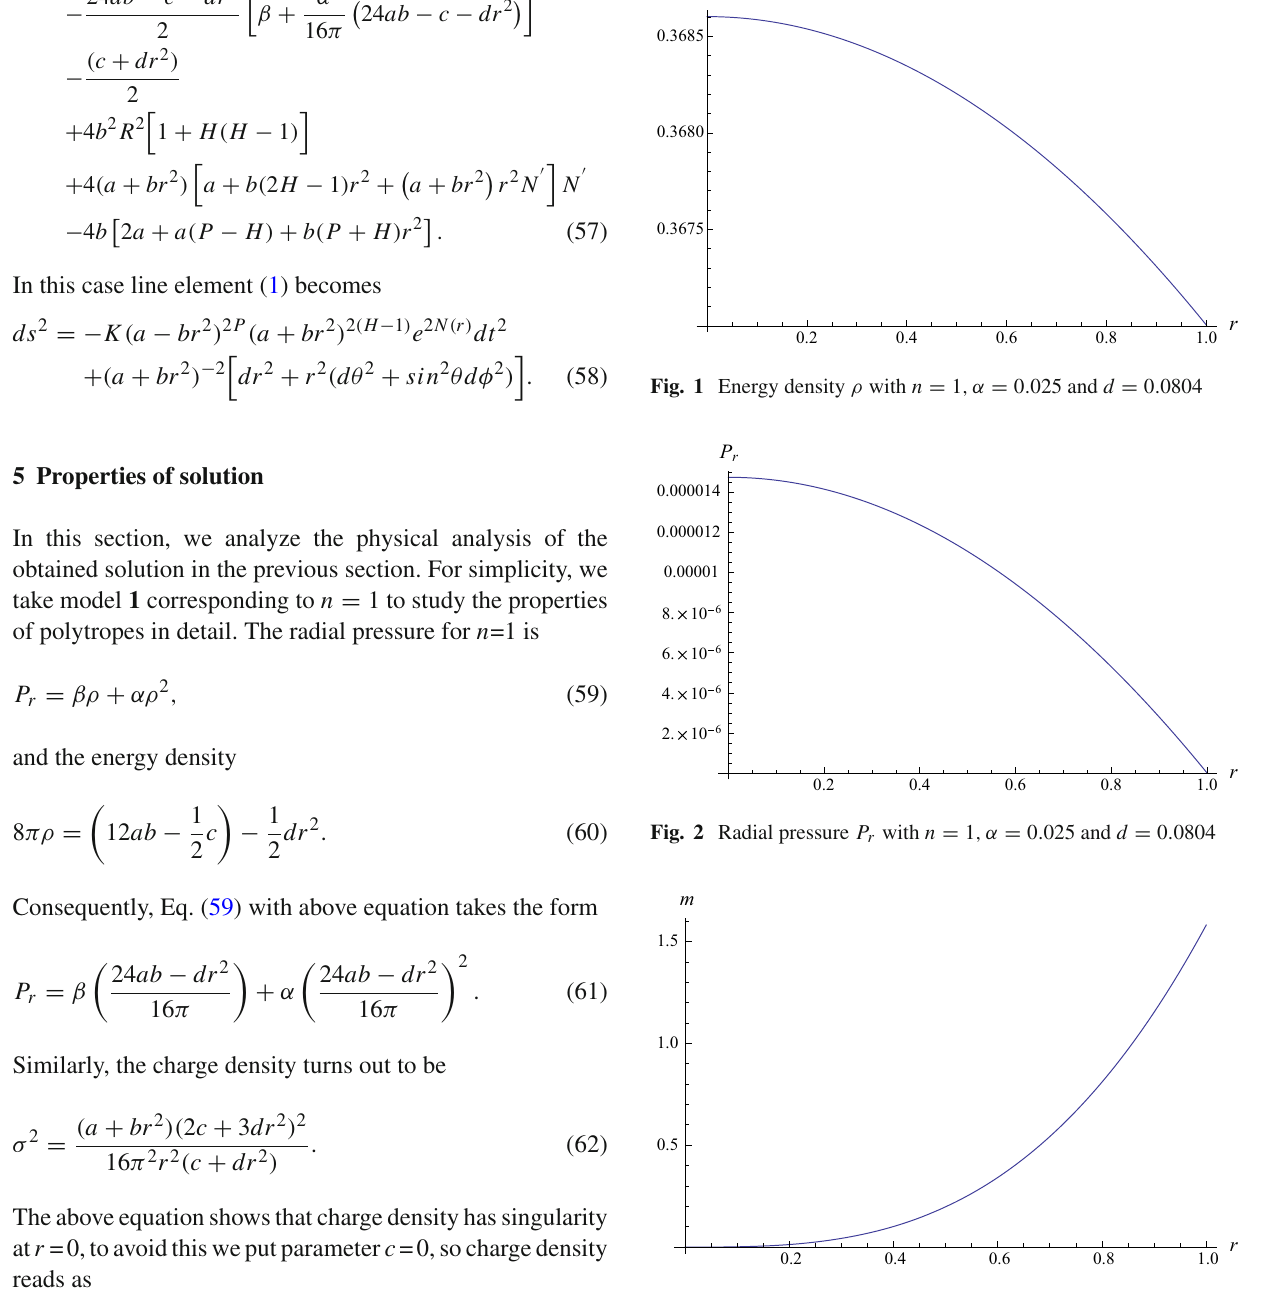
Fig. 3 Mass function m with for n = 1 ,α = 0 . 025 and d = 0 .